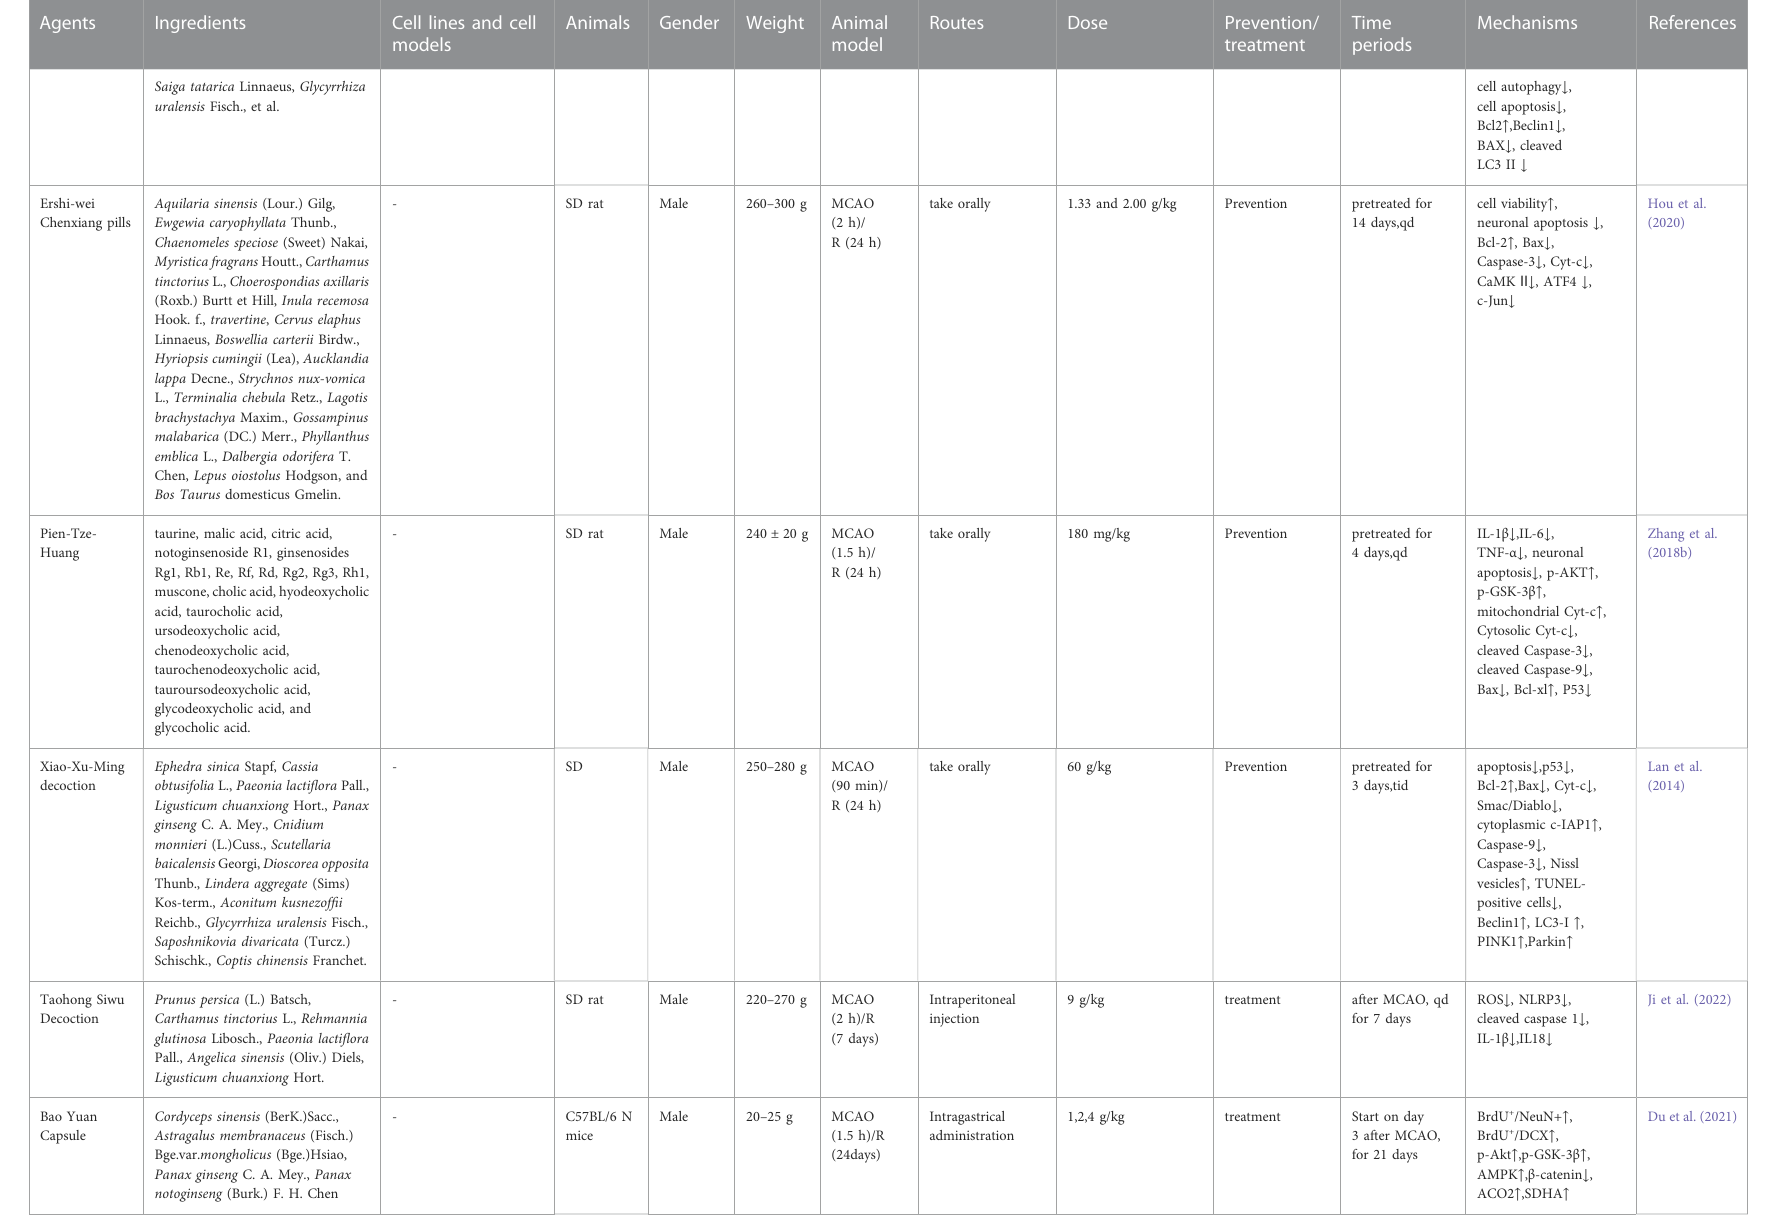
TABLE 4 ( Continued ) The molecular mechanism of TCM prescription in the treatment of ischemic stroke by targeting mitochondria.